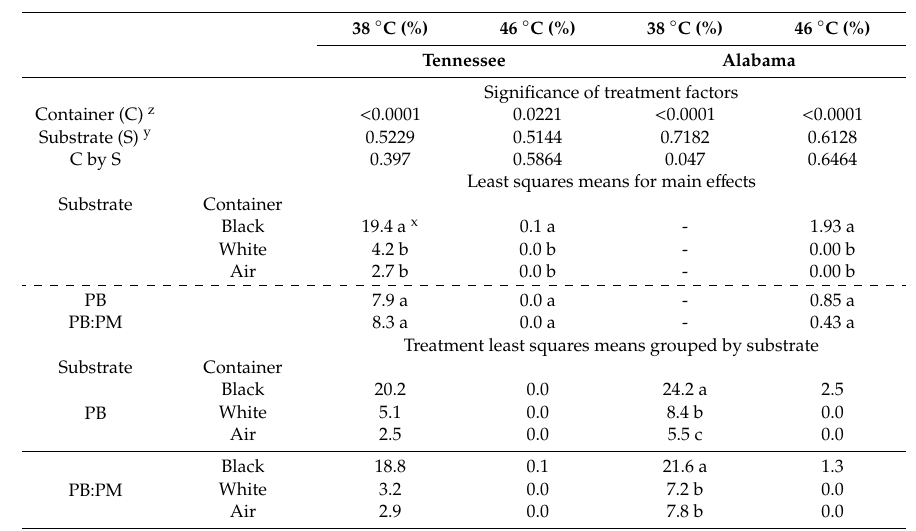
Table 4. Percent of time (n = 3) substrate temperature remained at or above critical thresholds (38 ◦ C and 46 ◦ C) during daylight hours for ‘Green Giant’ arborvitae grown in di ff erent types of containers and substrates in Tennessee and Alabama.